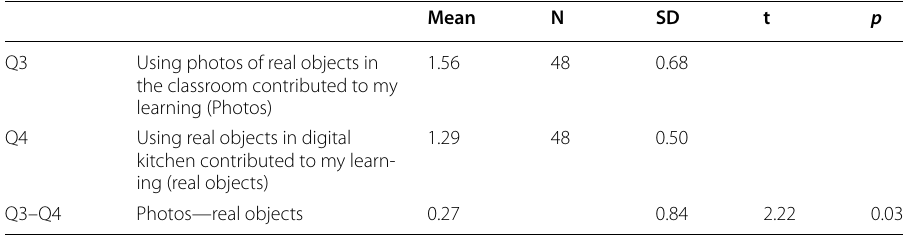
Table 3 Paired-sampled T-test on learning modes